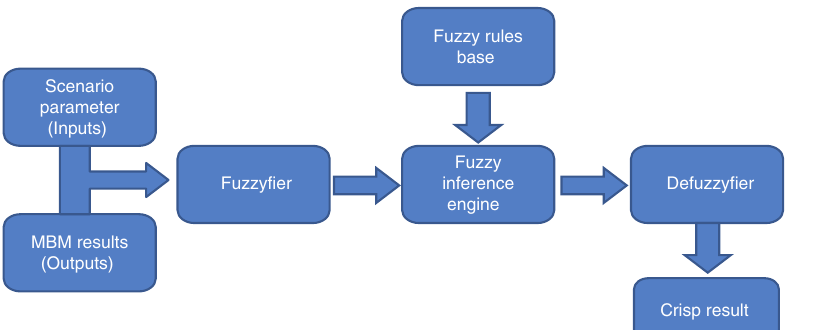
Figure 1: An Overview of the Fuzzy Logic